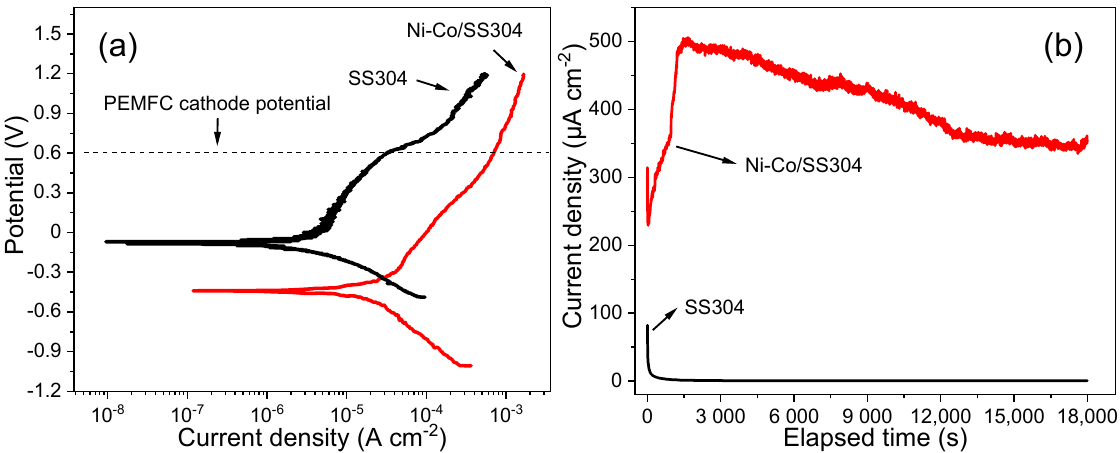
Figure 7. The polarization curves of SS304 and Ni–Co/SS304 in the simulated PEMFC cathodic environment: ( a ) potentiodynamic polarization curves, ( b ) potentiostatic polarization curves (0.6 V, 5 h).